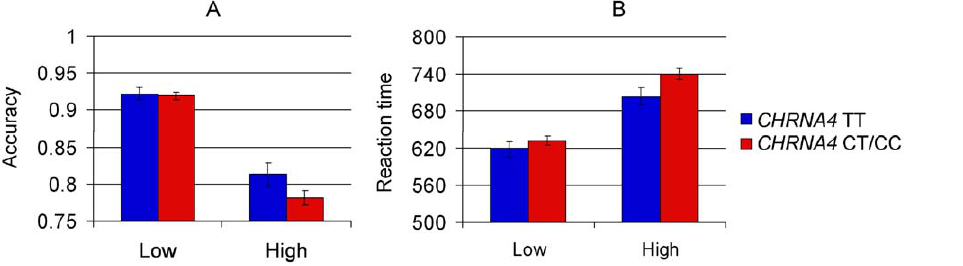
Figure 5. A: Mean accuracy in the visual search task for the CHRNA4 C- group versus the C + group as a function of load condition. B: Mean of median reaction time in the visual search task for the CHRNA4 C- group versus the C + group as a function of load condition. Error bars represent standard error of the mean.